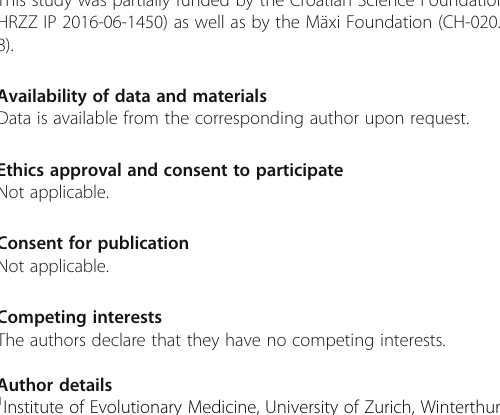
contributions, figure design, provision of funding. Ivor Jankovi ć : study design, writing contributions, provision of access to specimen. The author(s) read and approved the final